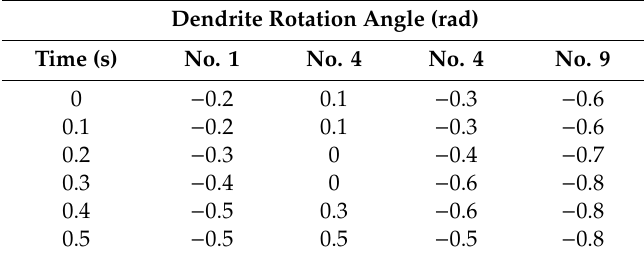
Table 2. Preferred growth angle of dendrites at di ff erent